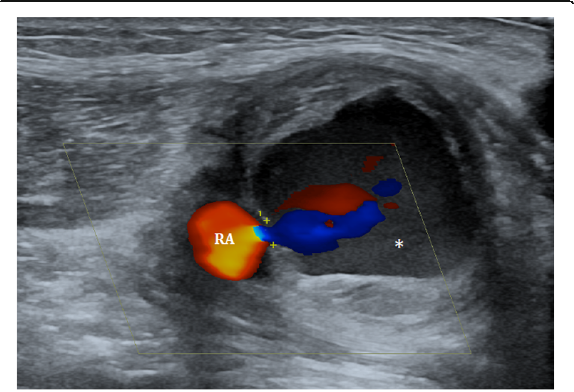
Fig. 1 Duplex ultrasound image of the pseudoaneurysm (*) arising from the radial artery (RA), in the transverse plane. The neck of the pseudoaneurysm (+) has no measurable length.